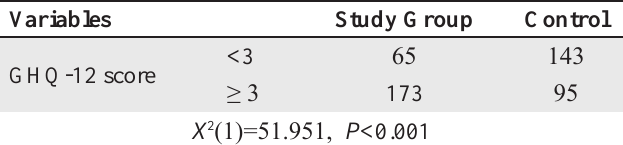
Table 3 : GHQ-12 scores of two